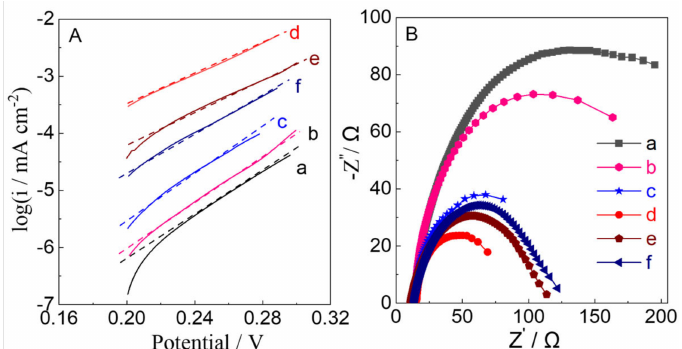
Figure 12. ( A ) Tafel plots and ( B ) Nyquist plots of (a) WO 3 − 0, (b) WO 3 − 0.62, (c) WO 3 − 1.2, (d) WO 3 − 2.5, (e) WO 3 − 5, and (f) WO 3 − 7.5 electrodes for photoelectrocatalytic water oxidation in a 0.1 M phosphate buffer solution (pH =